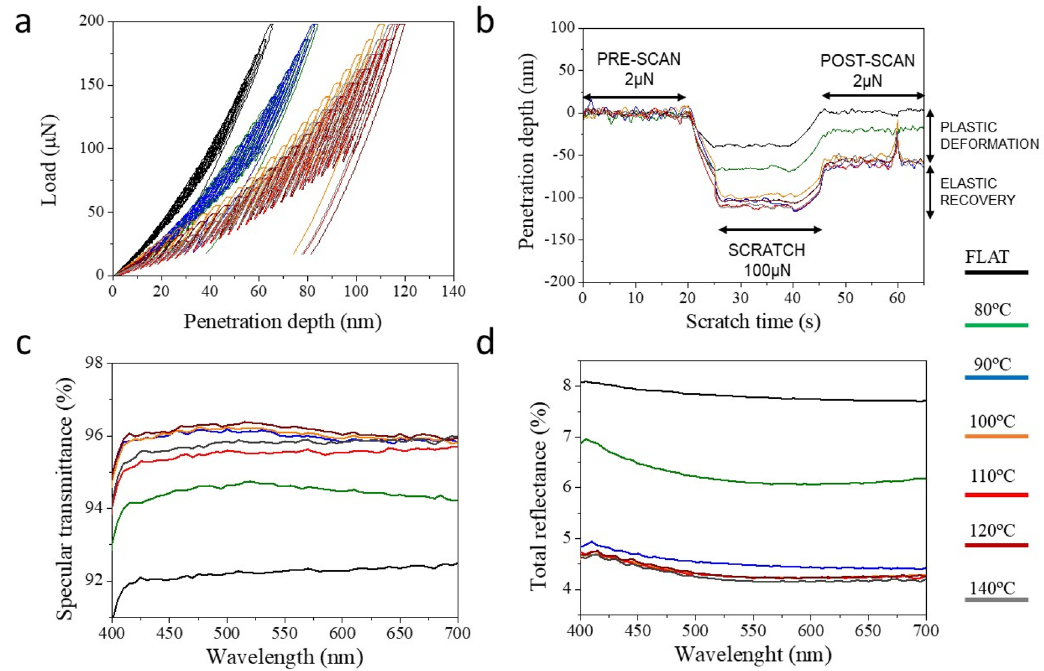
Figure 3. Summary of mechanical properties and broadband optical performance of the moth-eye R2R nanoimprinted PMMA films processed at web speed of 0.02 m·min −1 : ( a ) Representative nanoindentation loading–unloading curves. ( b ) Representative nanoscratch measurements obtained for a normal applied load of 100 µN. Three regions are plotted sequentially comprising the pre-scan, the scratch and the post-scan. ( c ) Specular transmittance spectra and ( d ) total reflectance